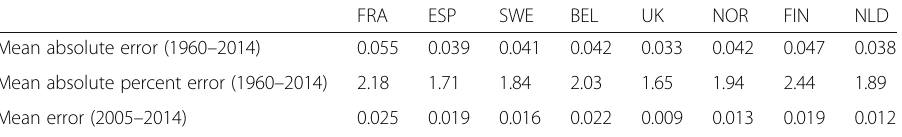
Table 7 Mean absolute (percent) error over the period 1960 – 2014 and mean error over the period 2005 – 2014 of the log death rates limited to age 65 and above of the Cairns-Black-Dowd method (ages 65 and above) estimated over the period 1960 – 2014, men and women combined